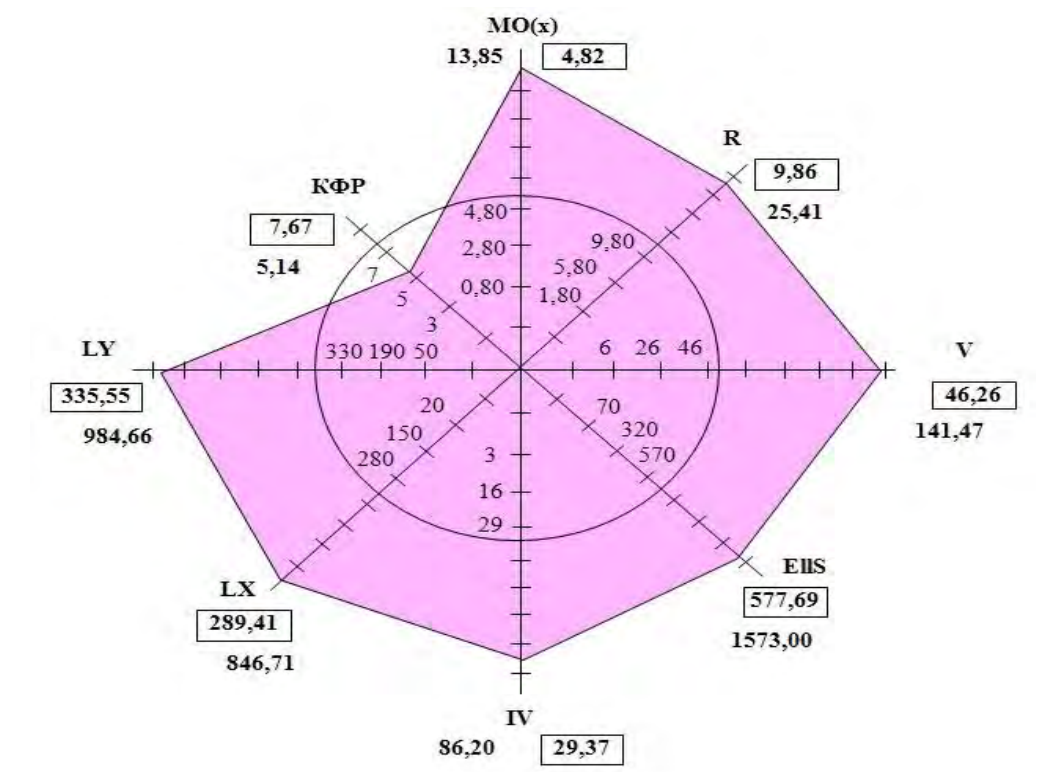
Fig.2. Graphic-analytical model of girls’ coordination